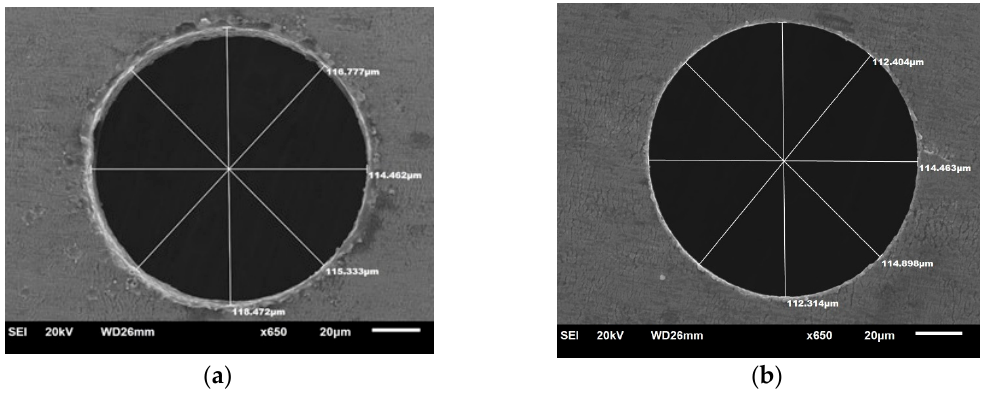
Figure 6. SEM image of hole drilled on Ni-Ti SMA: ( a ) using unoptimized parameters; ( b ) using optimized parameters.